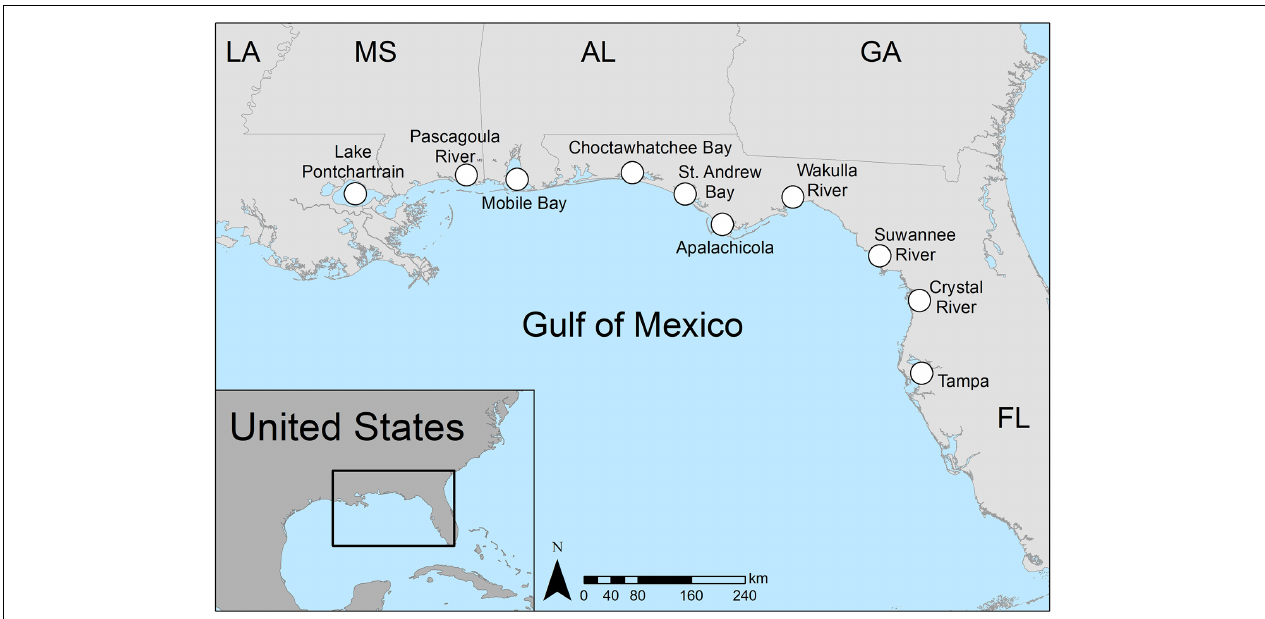
FIGURE 1 | Major stopover sites and terminal locations used by manatees migrating in the study area, along the northern Gulf of Mexico and peninsular Florida coasts.